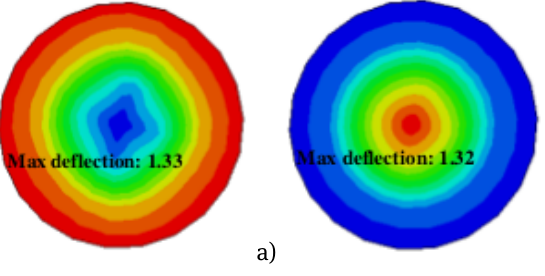
Figure 16: 16-ply specimens under a) flat and b) round nose im- pactor.